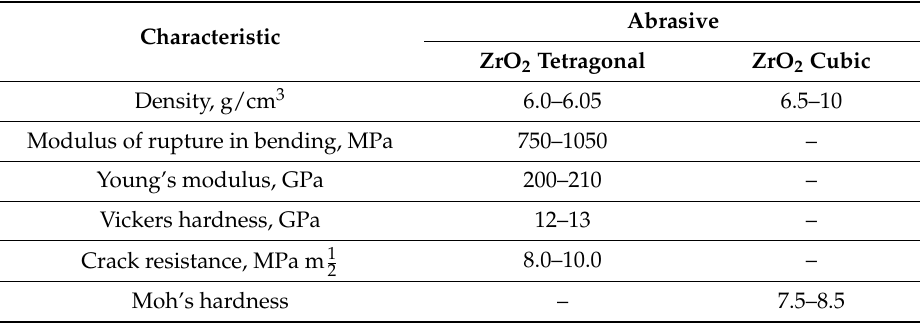
Table 1. Comparative characteristics of abrasives.